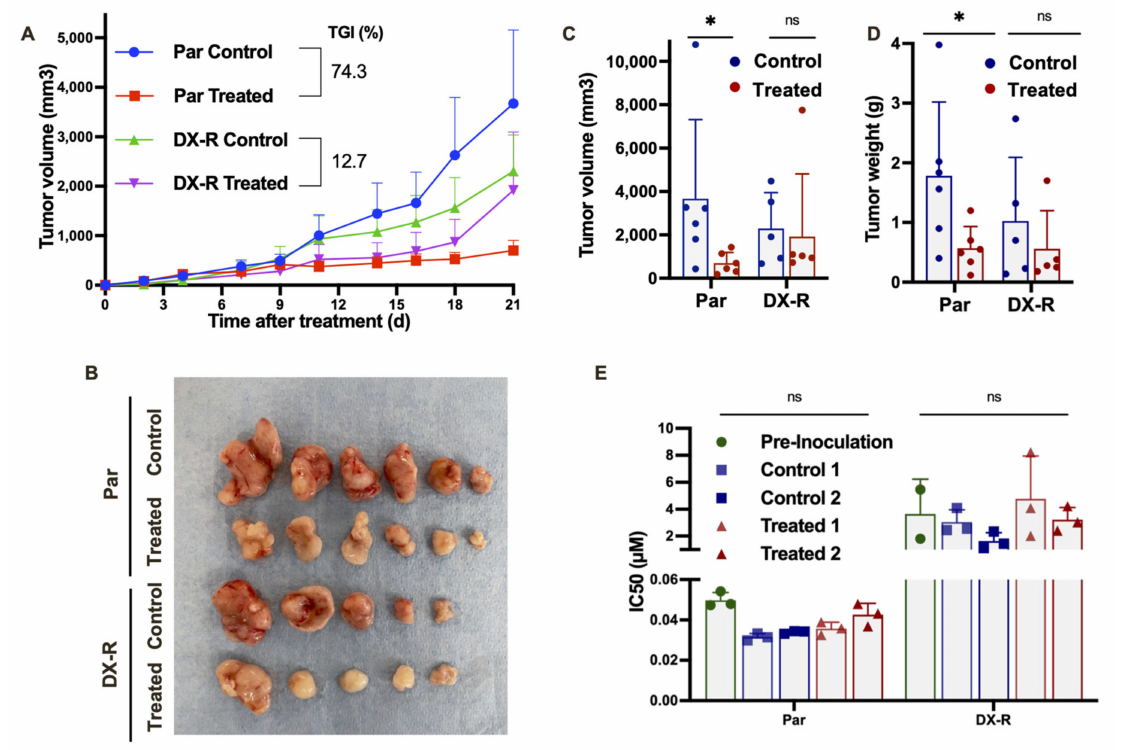
Figure 6. 143-B-DX-R cells maintain resistance in vivo. Mice carrying tumor xenografts generated by parental 143-B or 143-B-DX-R cells were randomly assigned to two different groups ( n = 6 per group) and treated i.v. either with saline buffer (control) or DOX at a dose of 4 mg/Kg twice a week (7 doses). ( A ) Curves representing the mean relative tumor volume of the different groups during the treatments. Drug efficacy is expressed as the percentage of TGI at the end of the experiment. Mean ± SEM is presented. ( B ) Image of the tumors extracted from the mice at the end of the experiment. ( C , D ) Distribution of tumor volumes ( C ) and weights ( D ) at the end of the experiment. ( E ) Comparison of the cytotoxic effect of DOX (IC 50 values) in parental 143-B and 143-B-DX-R cell lines before (pre-inoculation) and after (post-inoculation) in vivo tumor growth in immunodeficient mice. Error bars represent the SD and asterisks indicate statistically significant differences between groups in one-way ANOVA test (ns: p > 0.05; *: p ≤